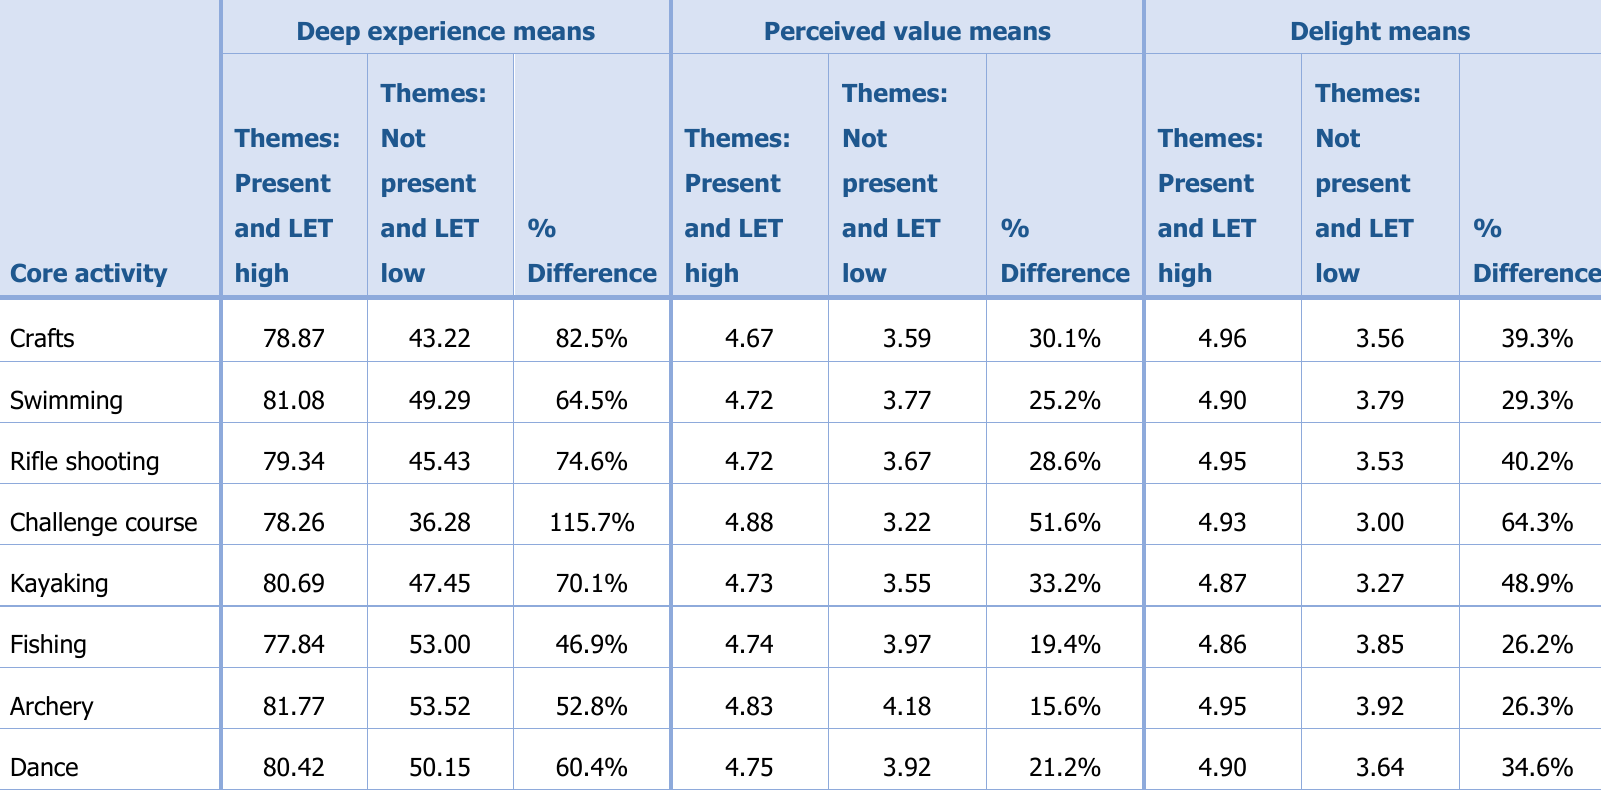
Table 1. Means per Activity for Theme Present and High LET vs. Theme Absent and Low LET Deep experience means Perceived value means Delight